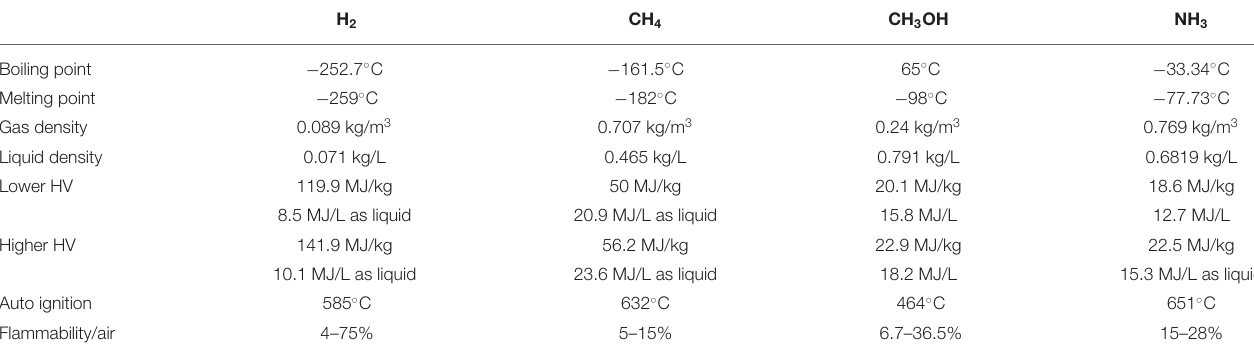
TABLE 2 | Chemical properties of hydrogen (H 2 ), methane (CH 4 ), methanol (CH 3 OH), and ammonia (NH 3